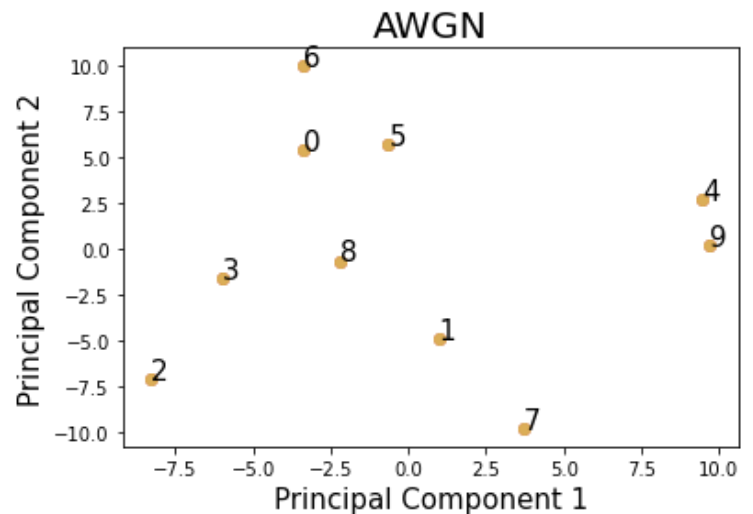
Figure 12. Two-dimensional principal component analysis projection of AWGN noise.